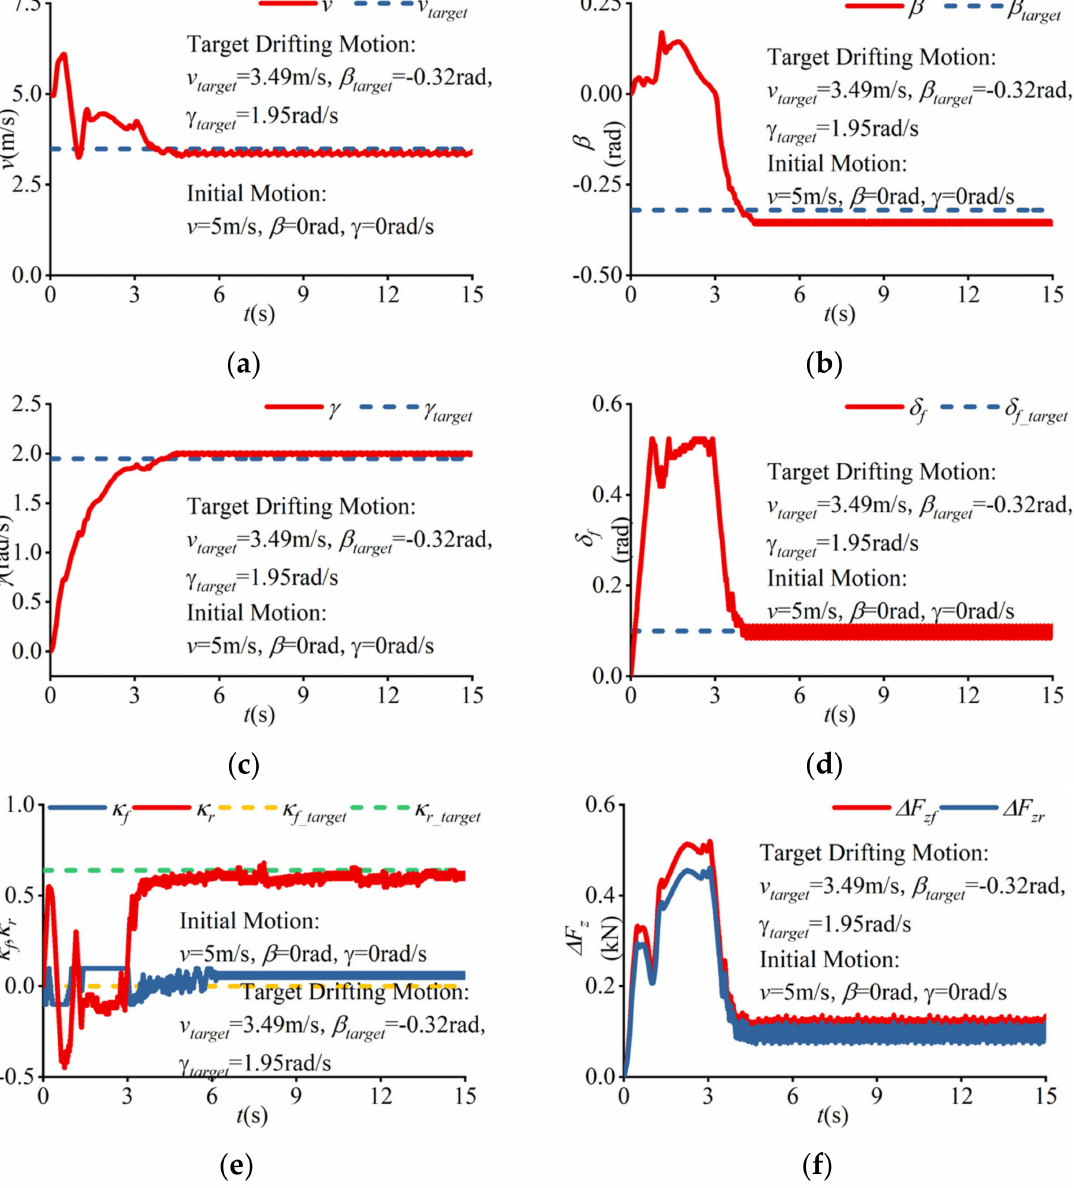
(cid:19) (cid:18)(cid:12) (cid:12)(cid:12) (cid:12) (cid:12)(cid:12) (cid:12) (cid:12) (cid:12) (cid:12) (cid:12) (cid:12) (cid:12) (cid:12) − F − F − /2 zfr zfr (cid:12) (cid:12) F zfl (cid:12) (cid:12) F zfl normal rolling active rolling